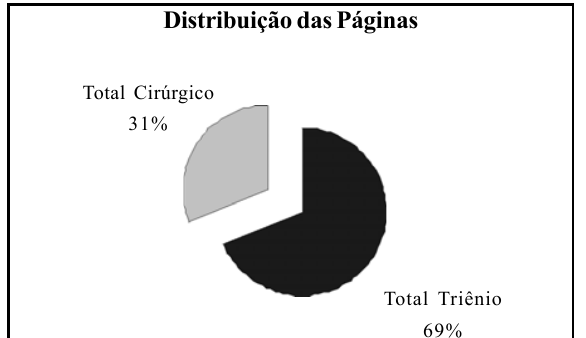
FIGURA 5 (cid:150) Mostra a porcentagem de pÆginas cirœrgicas em rela(cid:231)ªo (cid:224)s revistas selecionadas.